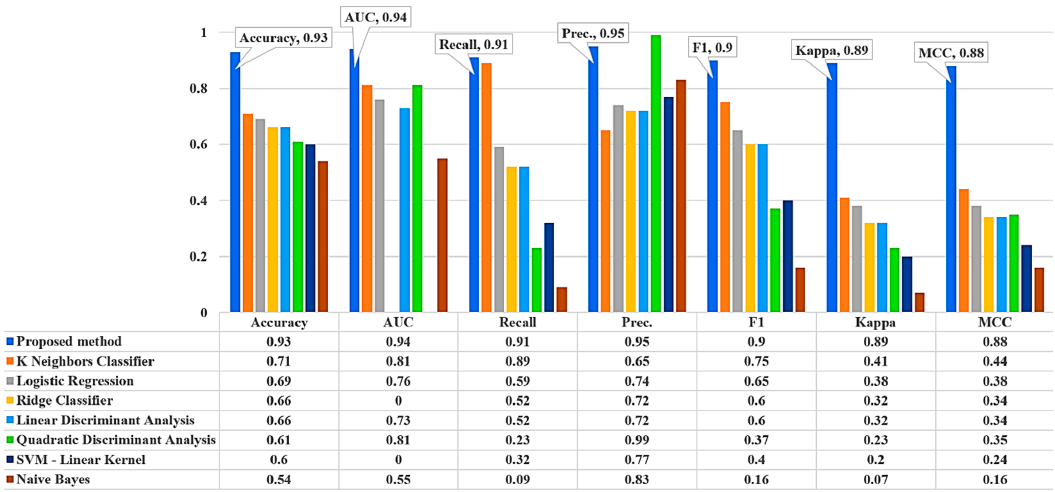
Figure 22. Performance evaluation of studied conventional ML models.